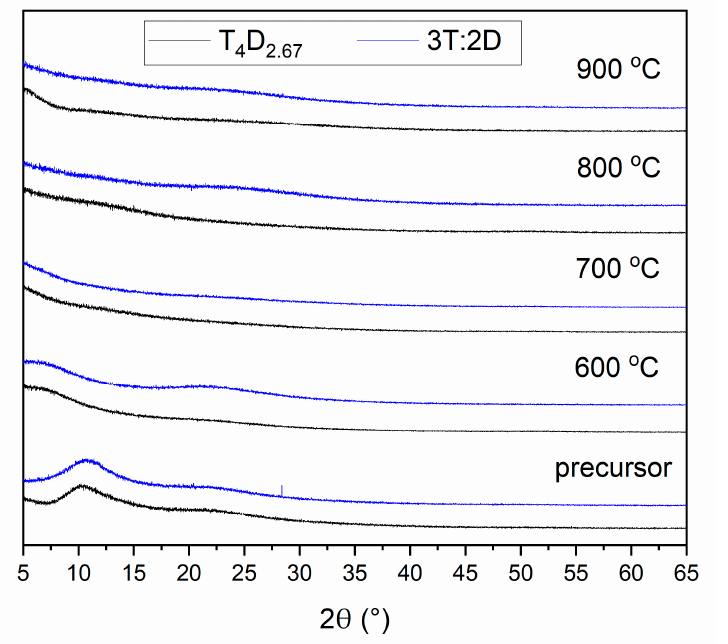
Figure 6. XRD analysis of materials obtained from precursors with 3:2 T:D ratio (T 4 D 2.67 and 3T:2D) after annealing at temperatures between 600 and 900 °C.